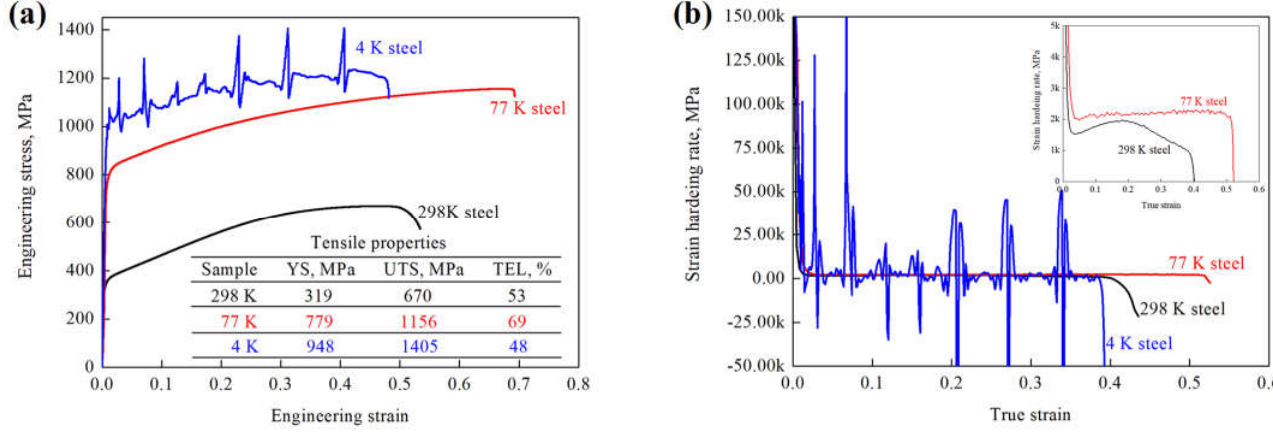
Figure 1. ( a ) Engineering stress–strain curves and ( b ) corresponding SHR curves derived from true stress–strain curves of the 298 K, 77 K and 4 K steels.